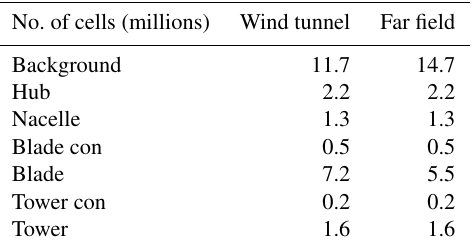
Table 4. Cell number in millions of the individual grids for the wind tunnel and far field